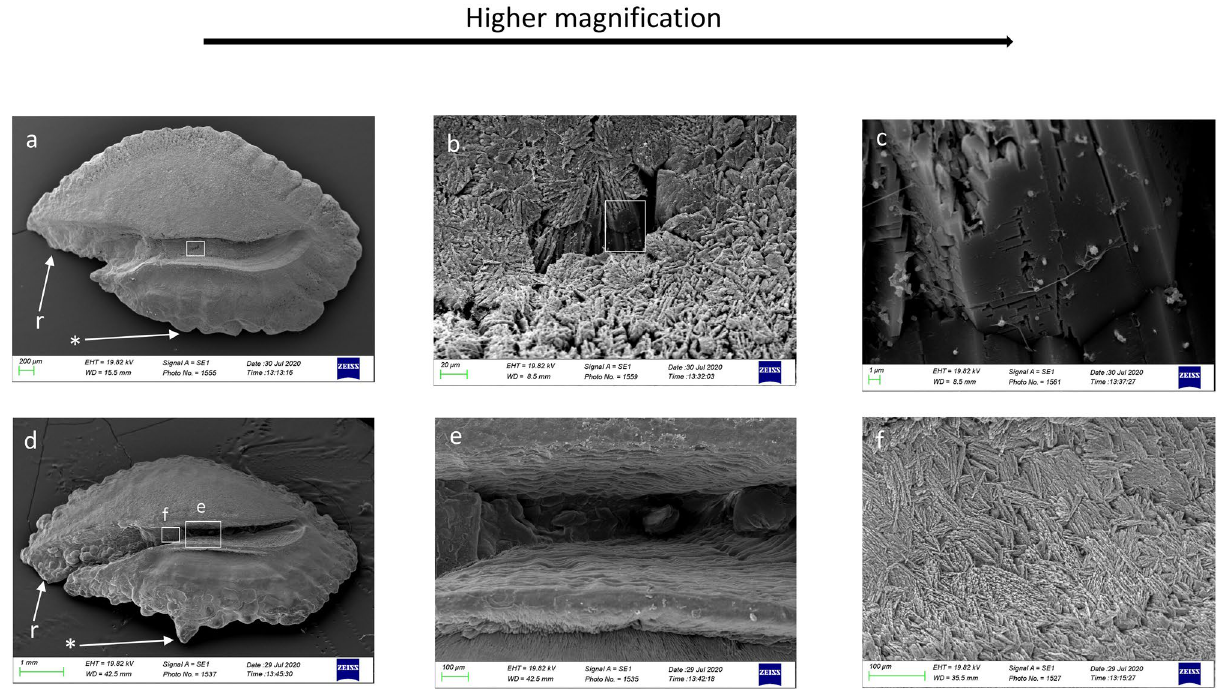
Figure 2. SEM images of the proximal surface of P. bogaraveo : juvenile ( a ) and adult ( d ) right sagitta , with details of a tip on sulcus acusticus surface ( b – c ), and details of external textural organization and crystalline structure ( f ) of caudal surface ( e ). (r) Indicates the rostrum and (*) indicates the dorsal rim.